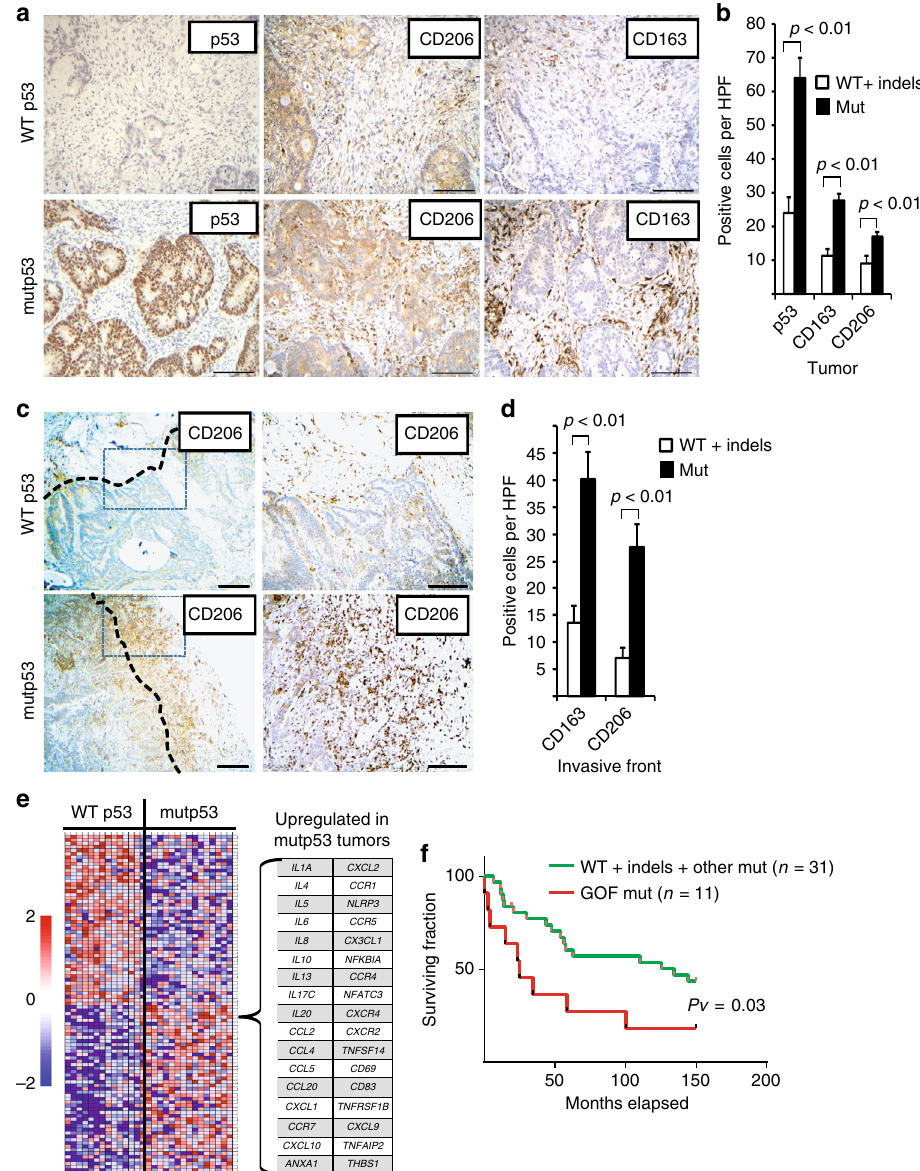
Fig. 5 Mutp53 positively correlates with TAMs in CRC patients. a Strong epithelial immunostaining of p53 in the cancerous glands is correlated with diffuse and strong immunostaining of CD163 and CD206 in the surrounding stroma, in a representative human CRC case carrying mutp53 compared with a WT p53 case. Bars represent 100 µ m. c Diffuse and strong CD206 immunopositivity in the invasive front of a mutp53 human CRC case as compared with a WT p53 case. The left panels display tumors at low magni fi cation where the invasive front is marked with a dashed line. The boxed area is displayed in the right panels at a higher magni fi cation. Bars represent 200 µ m in the left panels and 100 µ m in the right panels. b , d Staining abundance and intensity were calculated for all 42 specimens as described in the Methods section. Cases were grouped by p53 typing outcome — missense p53 mutations were de fi ned as “ mutp53 group ” , while insertions, deletions and no mutations were de fi ned as “ WT + indels group ” . The analysis was conducted either for the entire cancerous tissue (tumor, b ) or focused in tumor boundaries (invasive front, d ). e RNA from frozen tissue samples of 29 CRC cases was extracted and subjected to mRNA expression microarray analysis. The heatmap depicts the expression patterns of the genes whose abundance was signi fi cantly upregulated or downregulated between the “ WT + indels ” ( n = 13) group and the “ mutp53 ” group ( n = 16). A speci fi c molecular signature of genes upregulated in mutp53 CRC cases is detailed. f Survival curve of CRC patients divided by TP53 status comparing between the WT + indels combined with non-GOF p53 mutants (WT + indels + other mut) with patients carrying tumors with GOF mutations (GOF mut). Error bars represent standard